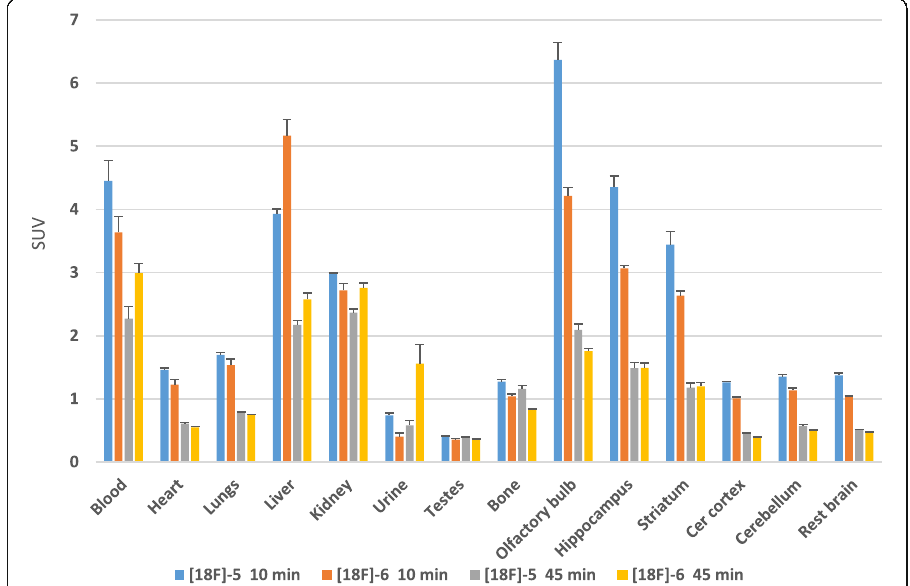
Fig. 3 Biodistribution of [ 18 F] 5 and [ 18 F] 6 in Sprague-Dawley rats ( N = 4) at 10 and 45 min after injection depicted in